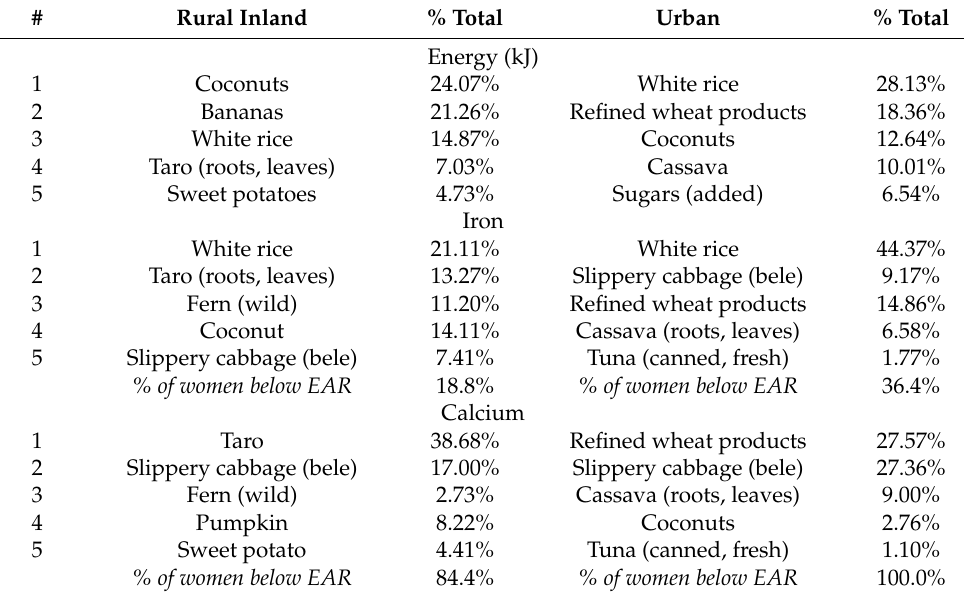
Table 4. Top five species contributing to energy, iron, calcium, vitamin A eq , and zinc in diets.